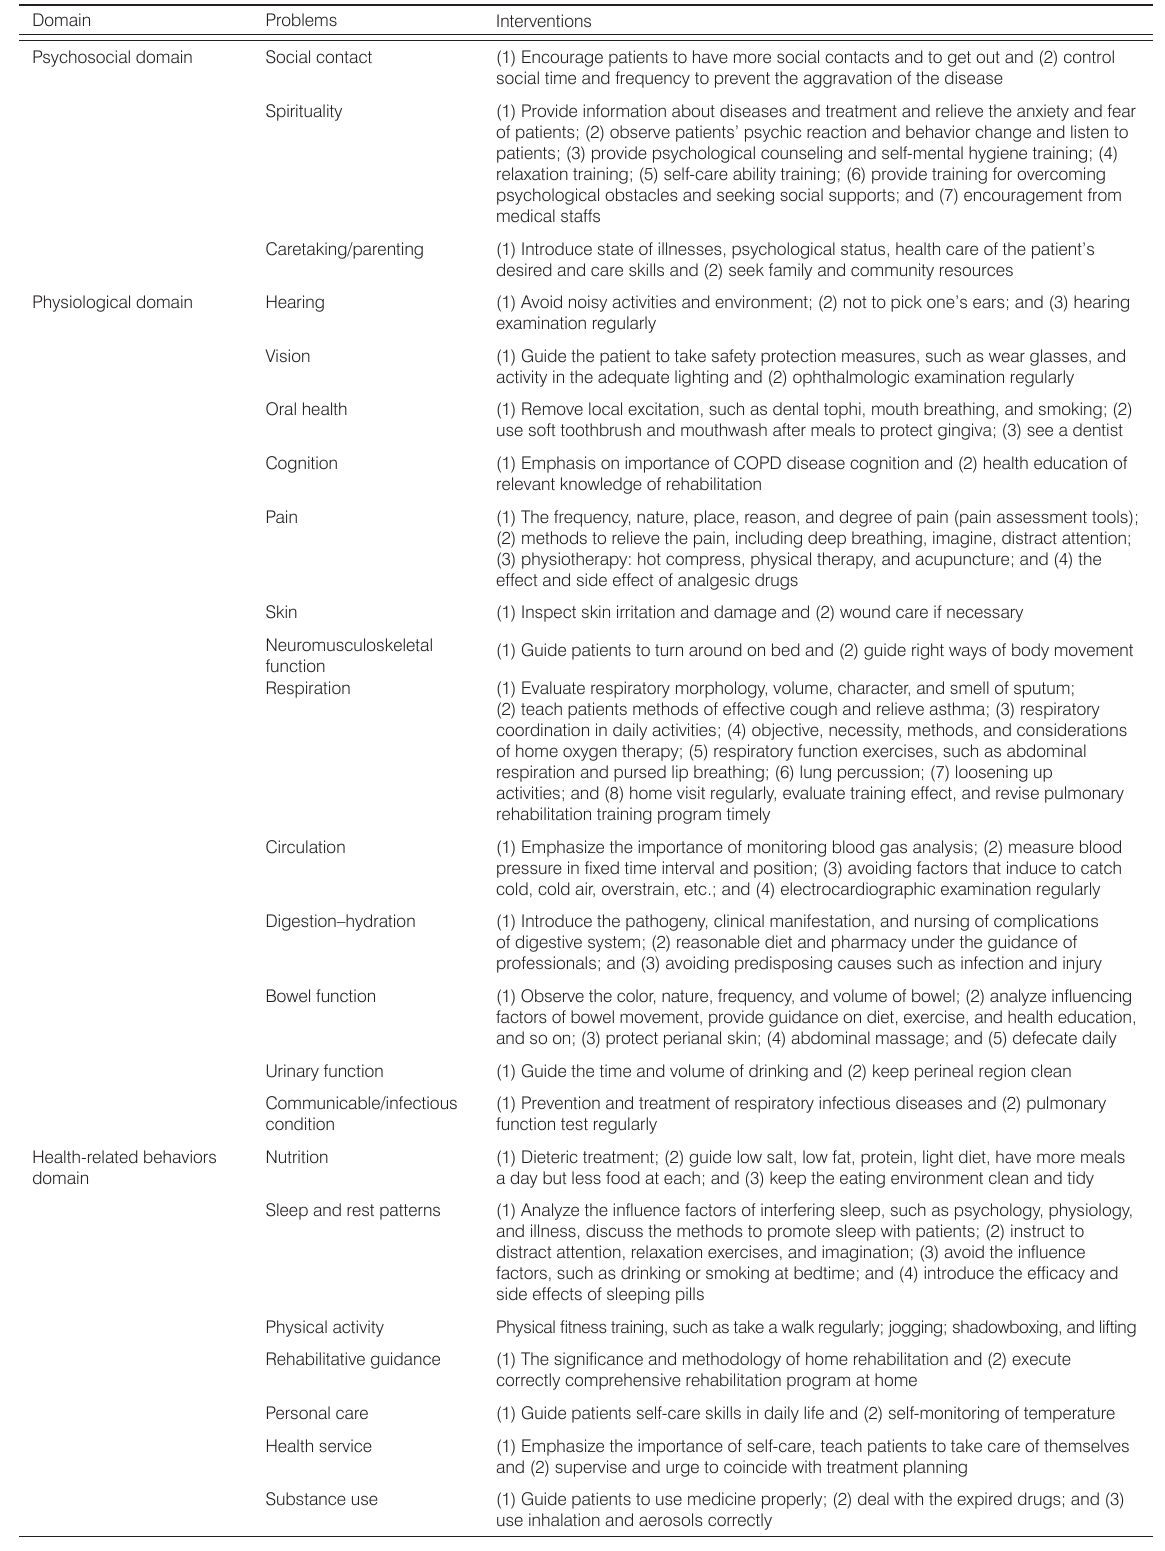
Table 1. Integrated care intervention